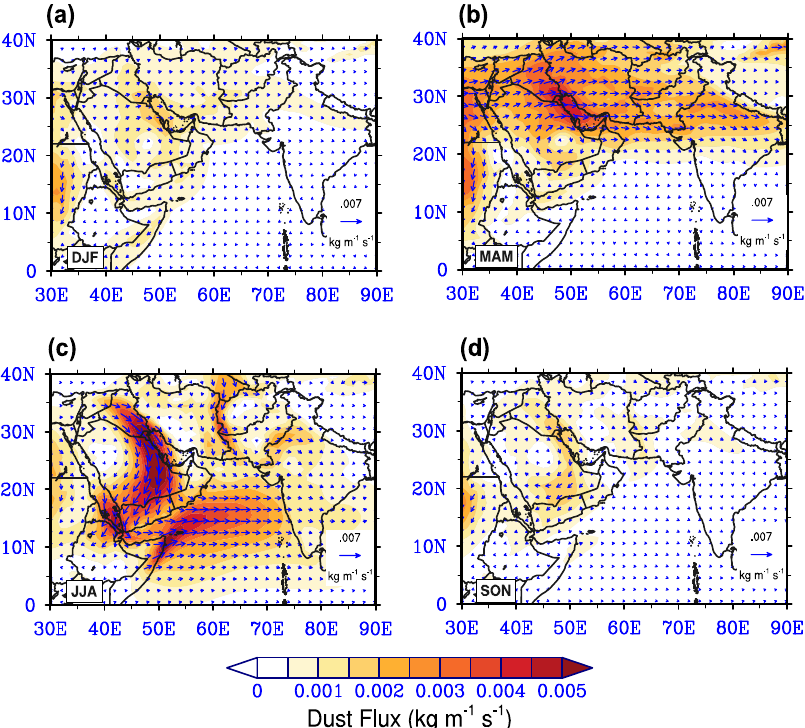
Fig. 8 Seasonal changes in the dust transport pathways. Seasonal climatology of MERRA-2 column integrated horizontal dust mass fl ux (shaded) and vectors for a DJF, b MAM, c JJA, and d SON, during the period 2007 –